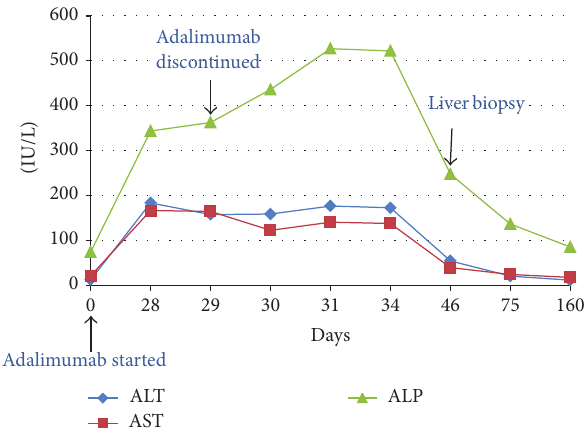
Figure 1: Graphic summary of biochemical liver injury with admin- istration of adalimumab in Subject 3. Aspartate aminotransferase (AST), alanine aminotransferase (ALT), and alkaline phosphatase (ALP).